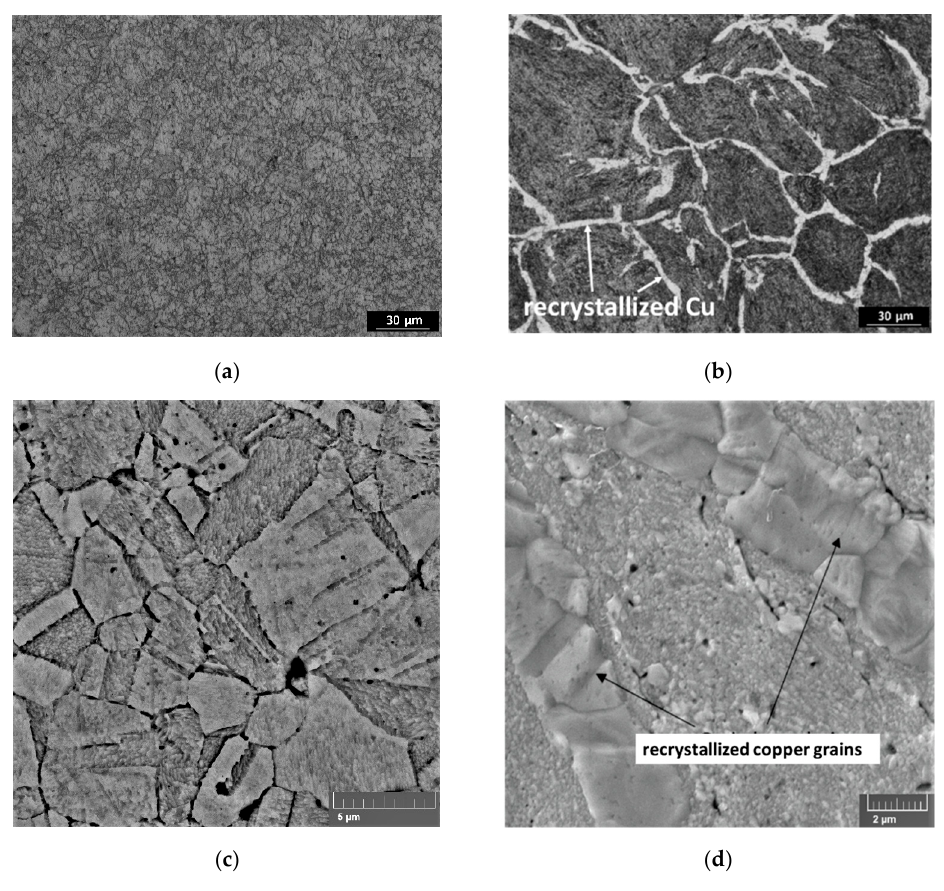
Figure 3. Optical ( a , b ) and SEM ( c , d ) images of the microstructure of the composite materials Cu-5.5 vol.% FS obtained by molecular level mixing ( a , c ) and mechanical milling ( b , d ).